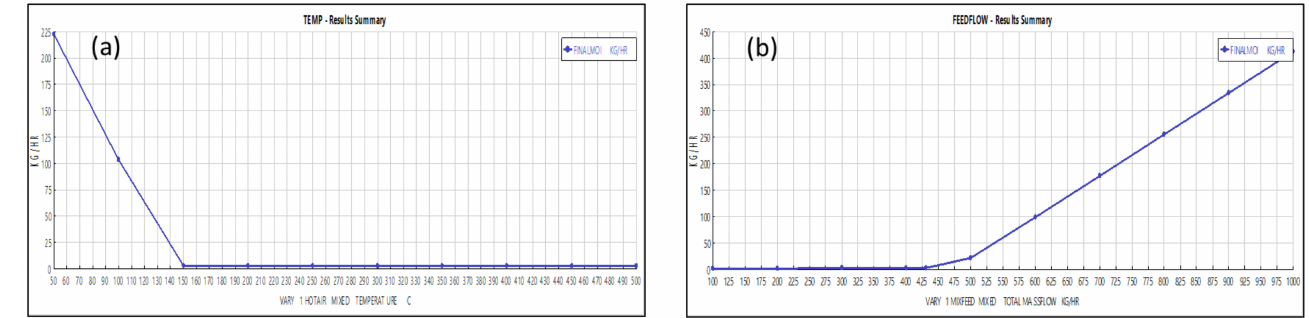
Figure 8. Effect of ( a ) inlet air temperature and ( b ) feed flow rate on the moisture content of the date sugar powder product.